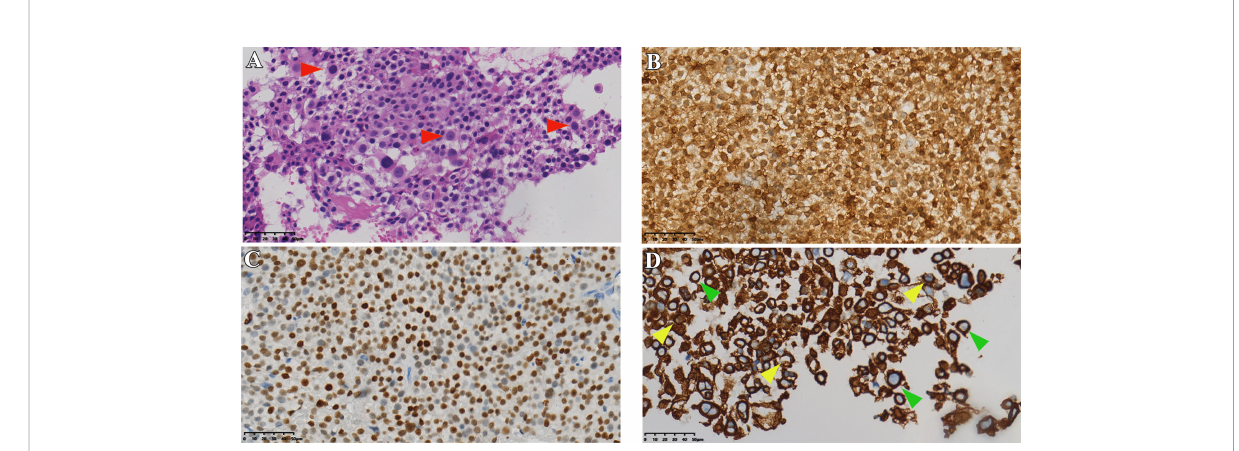
FIGURE 1 Histopathological dataof case1. (A) HE stainingof tumortissue (redarrowsindicate typical Crooke ’ shyalinechange). (B,C) Immunohistochemicalstaining for ACTH and T-PIT . (D) Immunohistochemical stainingof cellskeratinshowingCrookehyalinechanges(greenandyellowarrowsshowa roundand semi-circularimmunostainingof CK8/18 , respectively).Original magni fi